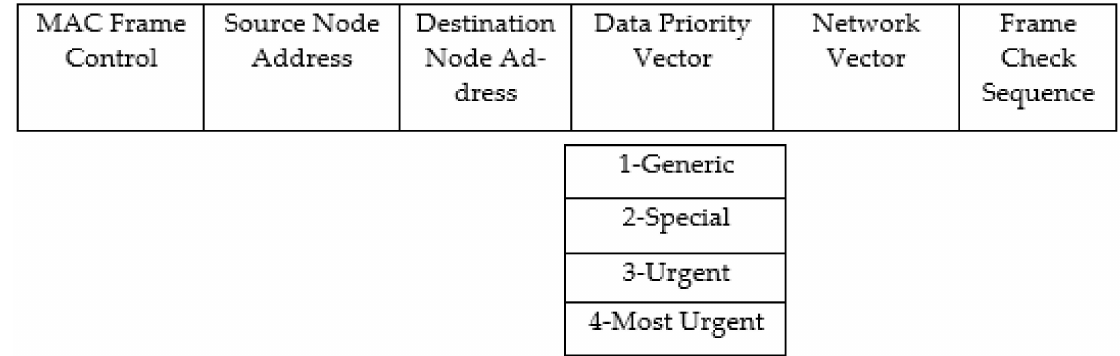
Figure 5. E4-QoS and MAC and data priority analysis.